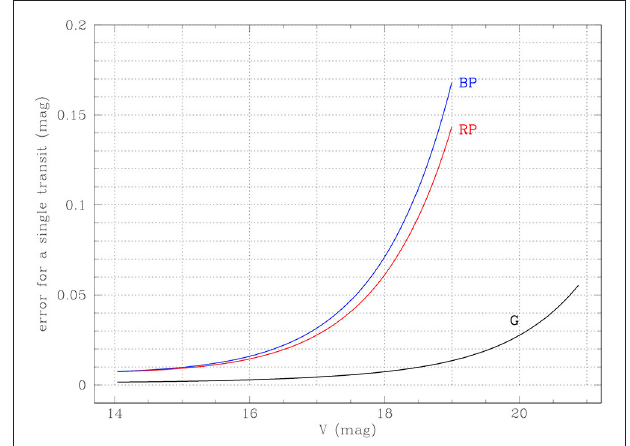
FIGURE 1 | Positional error after a 5-year mission as a function of V magnitude. The latter was derived from Gaia’s intrinsic G magnitude using the relation V = 1.02 G − 0.24, which is appropriate for quasars with z ≤ 4 ( Proft et al., 2015). Positional error estimate assumes a point-like source and follows Equations (4–7) from Prusti et al. (2016) with 0.54 < V − I < 0.98.